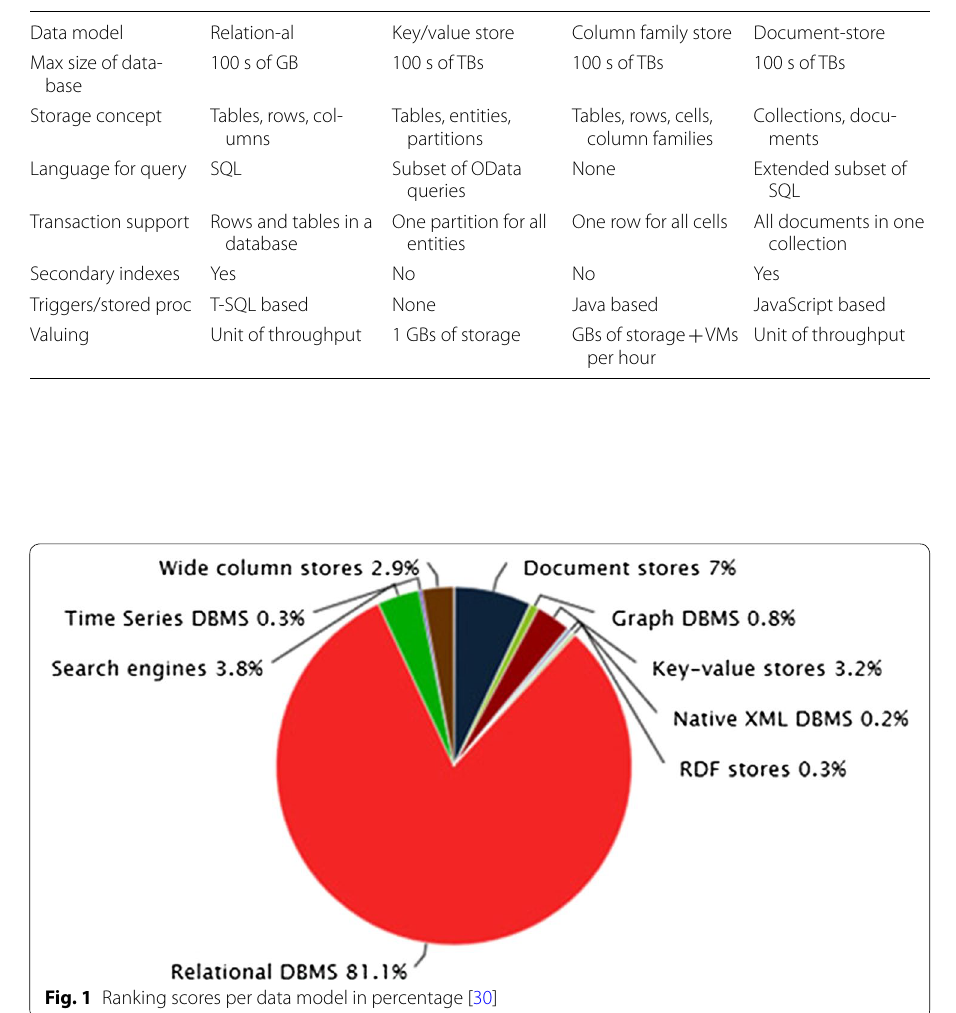
Table 1 How SQL databases relate to some NoSQL databases Heading level